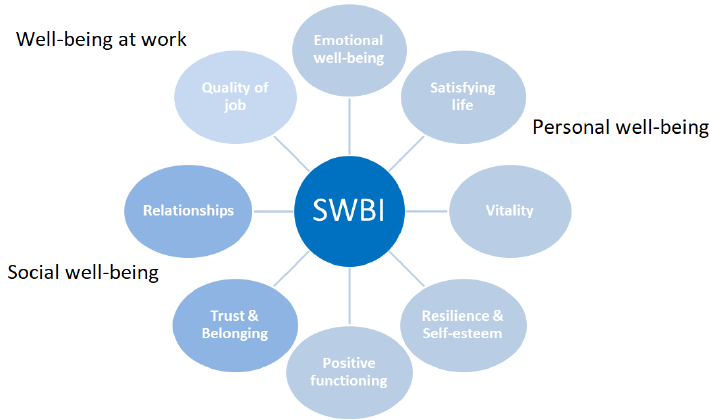
Figure 1. The SWBI framework. The three different shades of blue are defined according to the dimension of